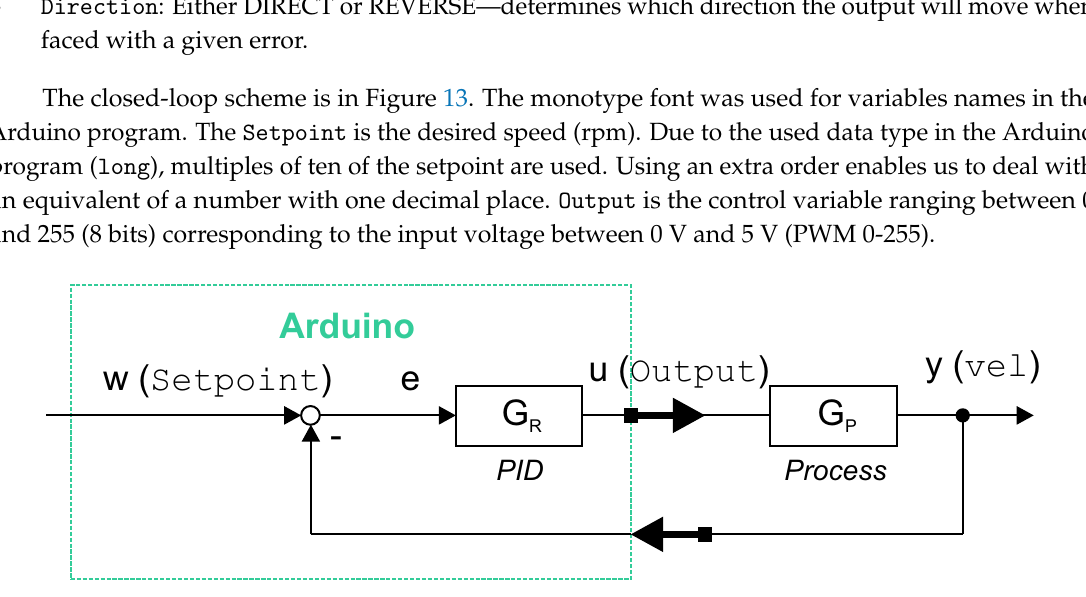
Figure 13. Block diagram of PID (proportional-integral-derivative) controller in a feedback